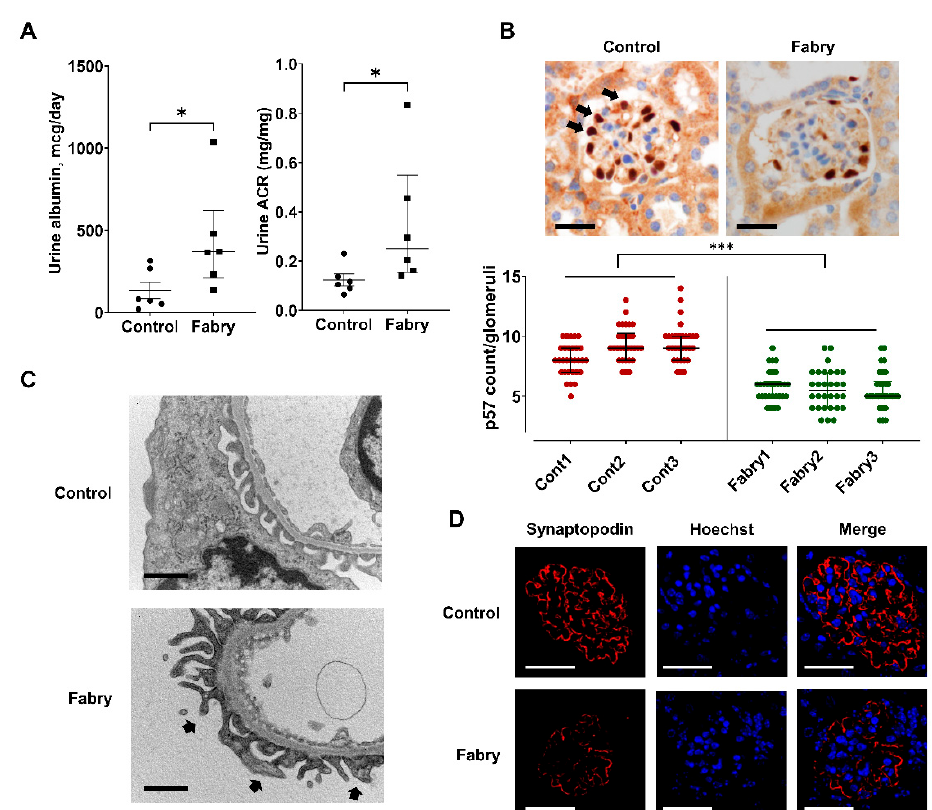
Figure 5. In vivo model of mouse treated with a single intraperitoneal lyso-Gb3 injection. ( A ) Albuminuria increased after lyso-Gb3 injection, suggesting lyso-Gb3 induced injury to the glomerular filtration barriers ( N = 6, median with interquartile range, * p < 0.05, by Mann–Whitney test). ( B ) Representative histological images of lyso-Gb3-treated and control mice. p57 stain (black arrow) was used to identify podocytes. The number of p57 stained cells per glomeruli was reduced in mice injected with lyso-Gb3. Magnification, 40 × ; bar = 20 µ m (three mice per group, 30 glomeruli per mouse, median with interquartile range, *** p < 0.001, by two-way ANOVA). ( C ) Representative TEM images of lyso-Gb3-treated and control mice. The control showed normal foot processes, whereas the mouse model mimicking Fabry disease showed partial segmental foot process effacement (black arrow). Magnification, 20,000 × ; bar = 1 µ m. ( D ) IF showed decreased synaptopodin staining (red) in the glomerulus of a mouse injected with lyso-Gb3. Magnification, 40 × ; bar = 20 µ m.